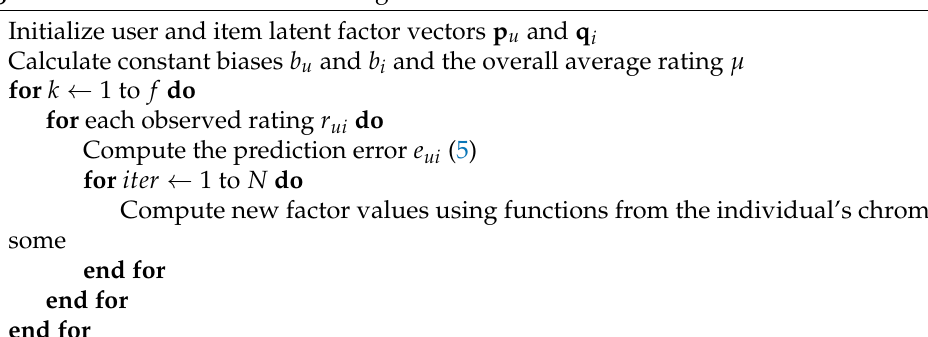
Algorithm 2 GE enhanced stochastic gradient